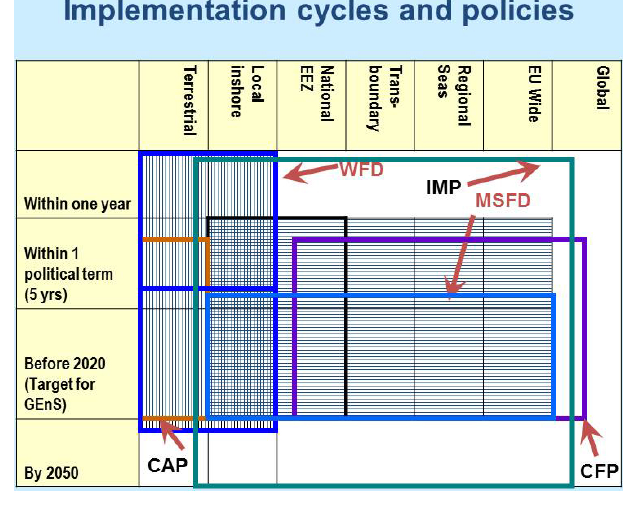
Fig. 6 . Decision space analysis matrix of policies relevant to the European marine environment, Water Framework Directive (WFD), Common Agricultural Policy (CAP), and Common Fisheries Policy (CFP) (EEZ = Exclusive Economic Zone; GEnS = Good Environmental Status; IMP = Integrated Maritime Policy; MSFD = Marine Strategy Framework